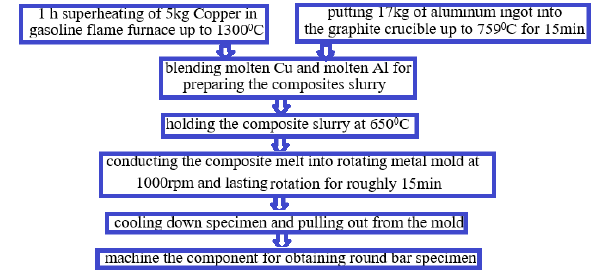
Figure 1: Schematic diagram of horizontal centrifugal casting ap- plied for fabricating Al-Al 2 Cu FGM, all dimension in millimeter V fabricated by TECO E310 company series were applied to regulate the rotational speed of mold. Steel is consid- ered for material of mold and also geometrical properties of mold are assumed to be 12 mm in thickness ( t ), 240 mm in length ( L ) and 100 mm in inner diameter ( D ) with L / D equals to 1.2.